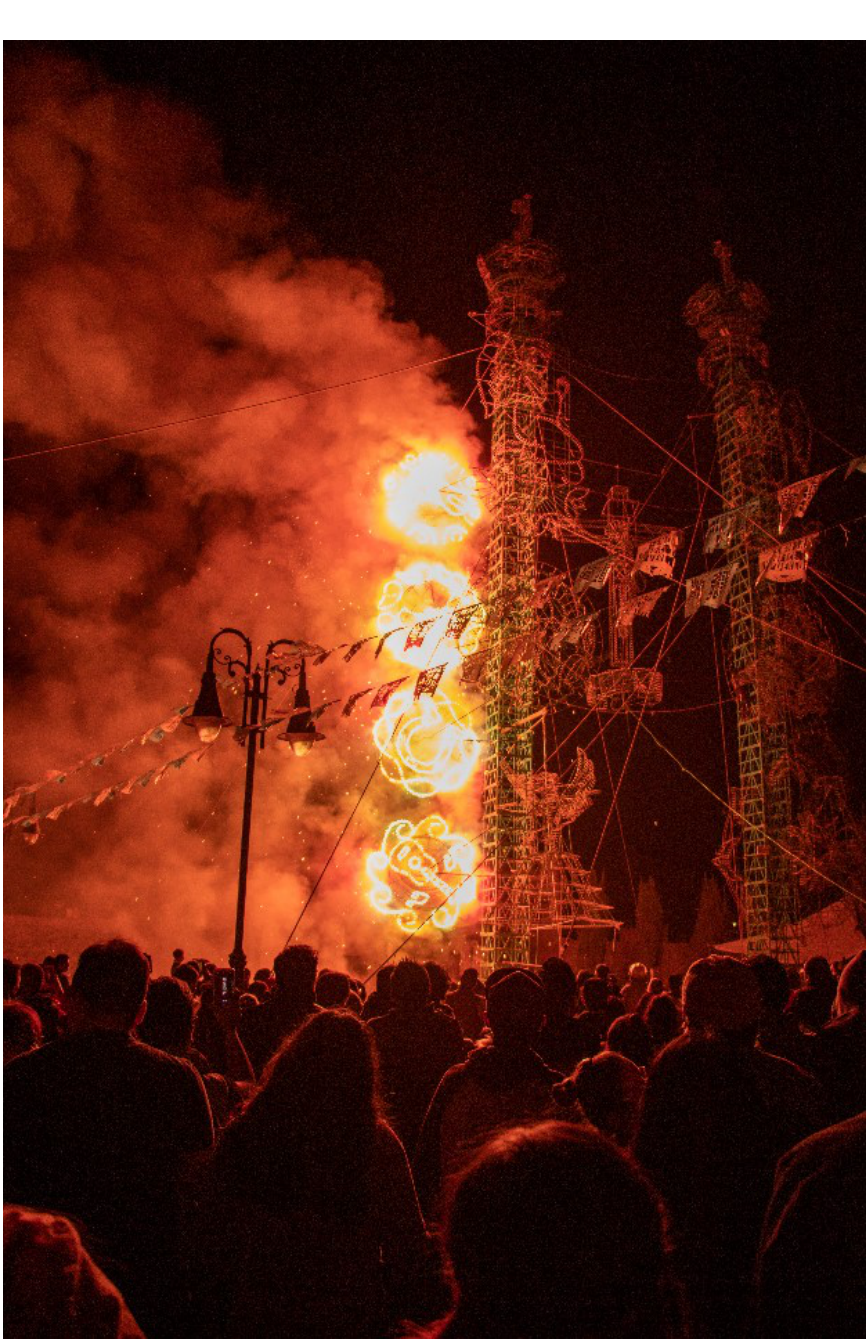
Figure 3 Burning of fireworks ‘castles’ during the feast in honor of Our Lord of Gracias, 2019. Tep- expan, Acolman, State of Mexico. Copyright: Isaac Trenado